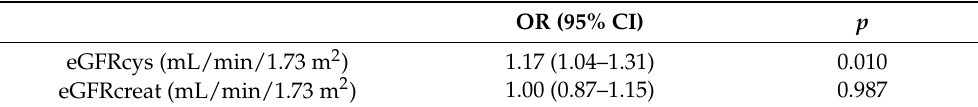
Table 3. Association between the baseline eGFRcys or eGFRcreat and recovery from severe eGFRcreat depression a ( n = 34).